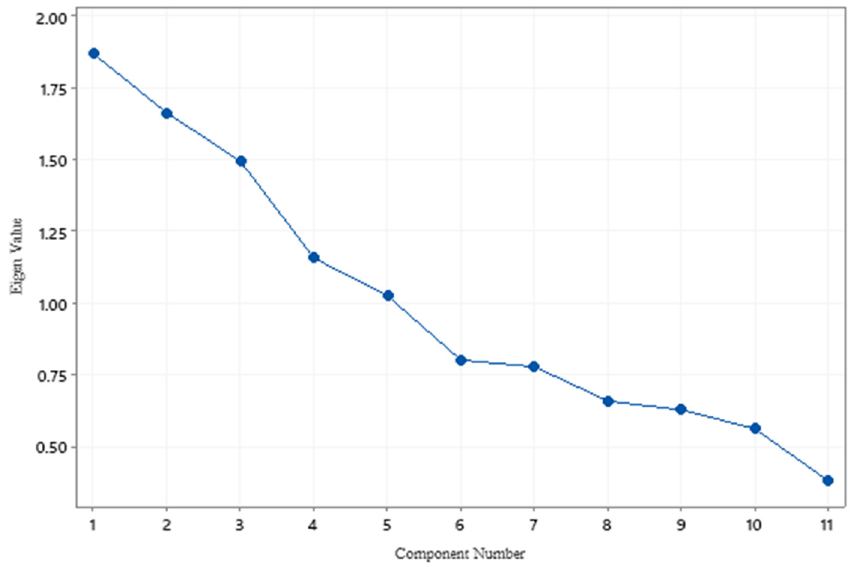
Figure 2. Scree plot of eigenvalues in the Hau River.